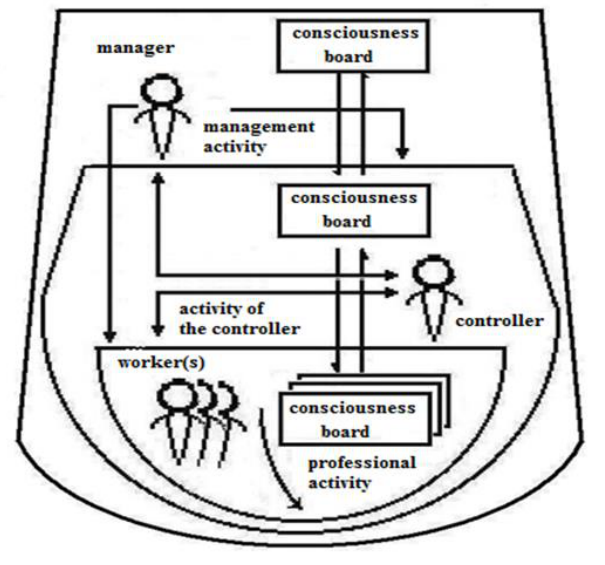
Figure 3. Stratification of collective activity structure because of its complication due to introduction of controller